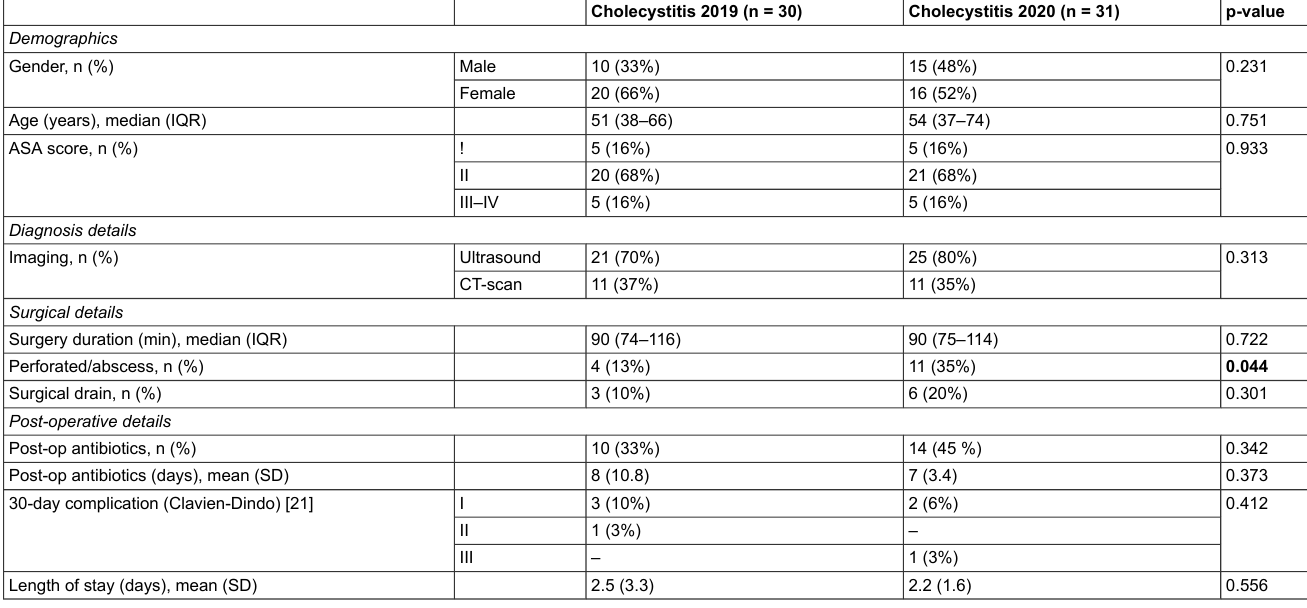
Table 2: Baseline demographics, diagnosis, surgical and post-operative details for Cholecystitis: comparison between 2020 and